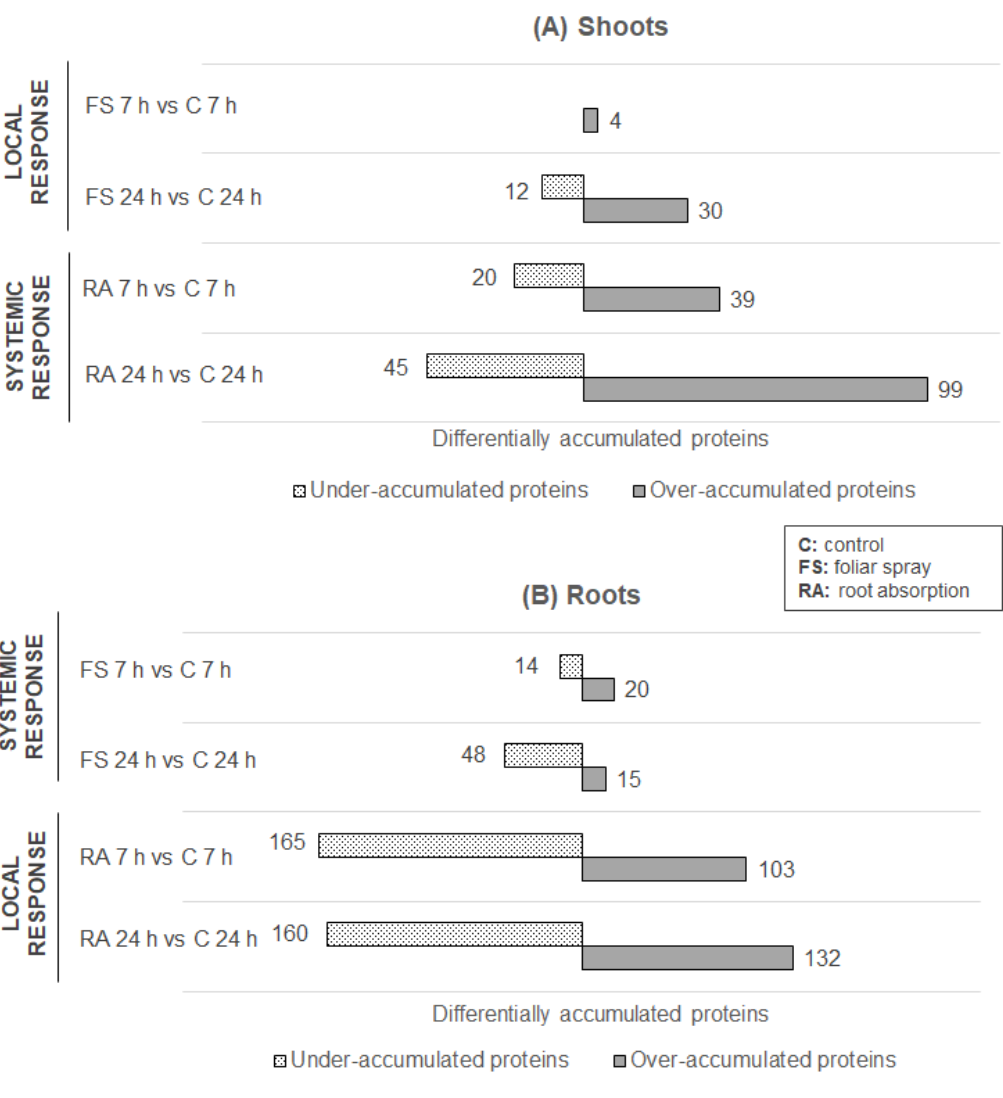
Figure 1. Differentially accumulated proteins (DAPs) in shoots ( A ) and roots ( B ) of B. napus var. Darmor- bzh treated with RLs versus control. Four RL treatment conditions were tested: foliar spray treatment (FS) and root absorption treatment (RA), during 7 h or 24 h. The DAPs are identified according to Blast2GO (https://www.blast2go.com (accessed on 13 October 2022)) and Uniprot database (https://www.uniprot.org (accessed on 12 October 2022). These experiments were performed on three biological replicates.